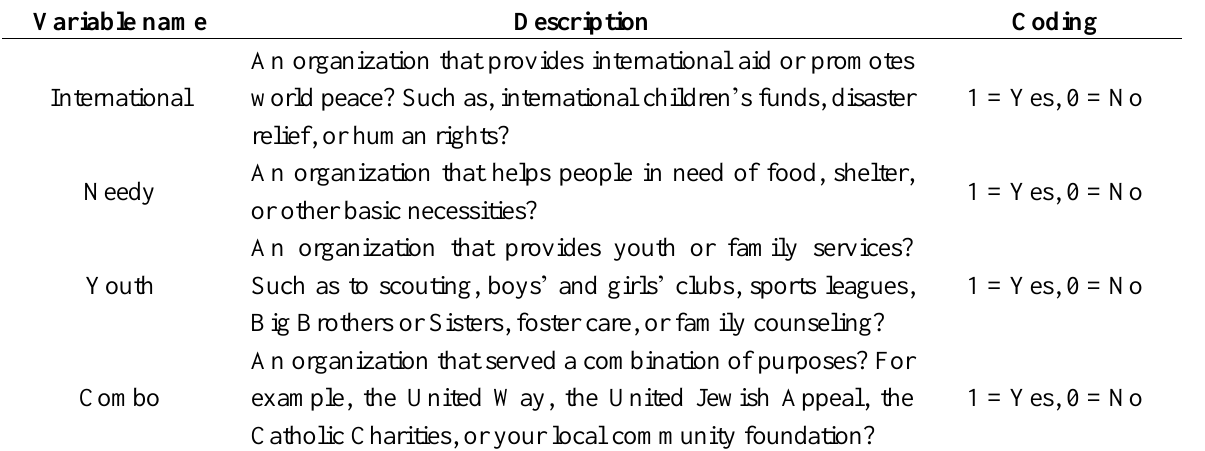
Table 1. Dependent Variable